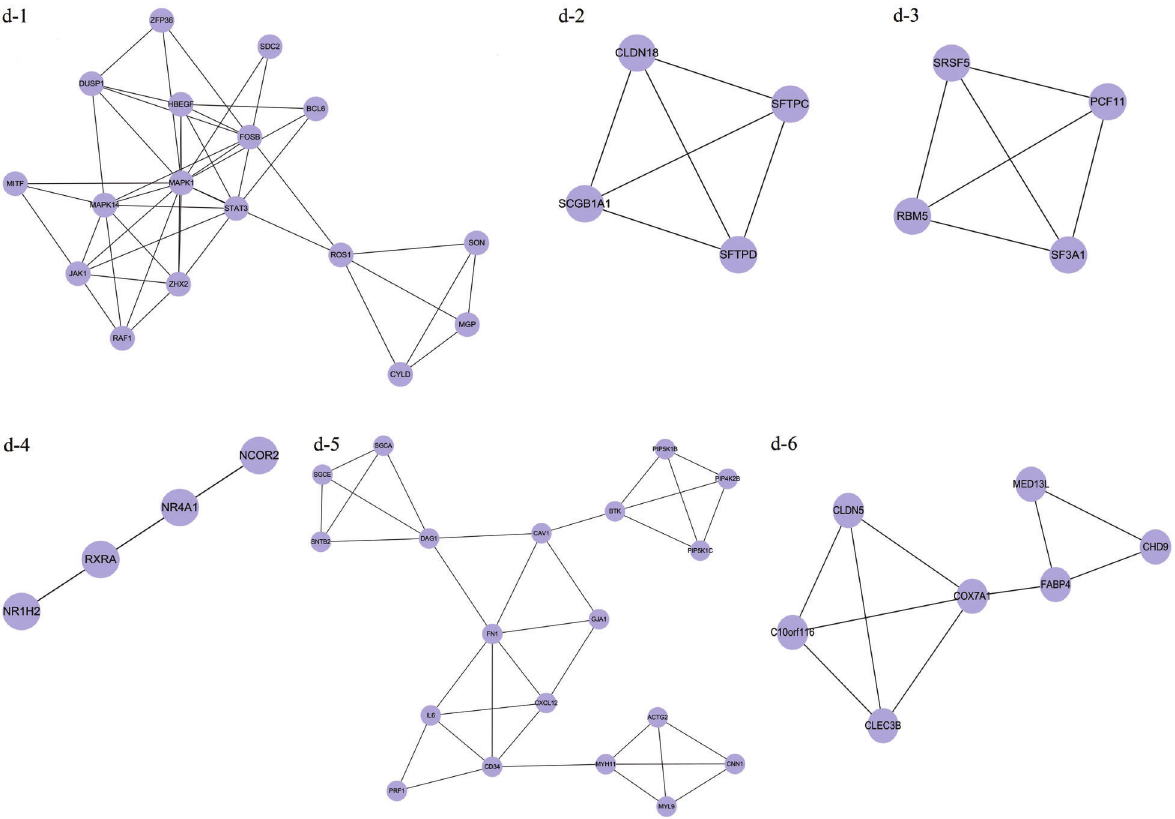
Figure 4. Modules of the protein-protein interaction network for downregulated differentially expressed